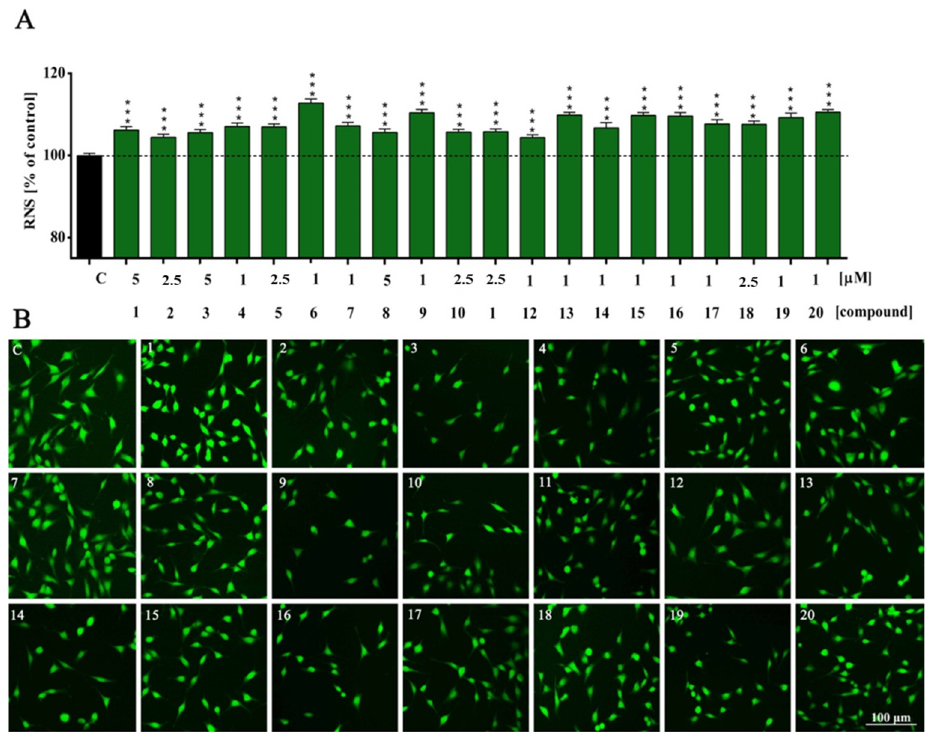
Figure 4. Nitric oxide (NO) level of HT-22 cells treated with compounds 1–20 ( A ) for 48 h and representative images ( B ). All experimental groups were compared using one-way ANOVA of variance with Dunnett’s post hoc test; mean ± SD, n = 9. Statistically significant results are displayed as: *** p < 0.001. Green fluorescence—FITC. Magnification of the objective lens 10×. The NO overproduction we observed is probably directly related to low Ca 2+ levels.